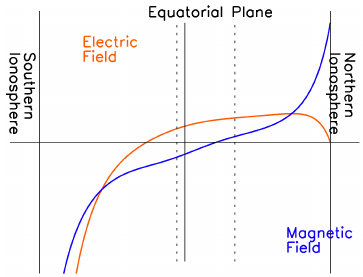
Fig. 13. Resulting wave structure when a 17.2mHz wave is fed into the Runge-Kutta algorithm. The vertical dashed lines again show the scaled positions of the Cluster spacecraft 3 (right of the equatorial plane) and 4